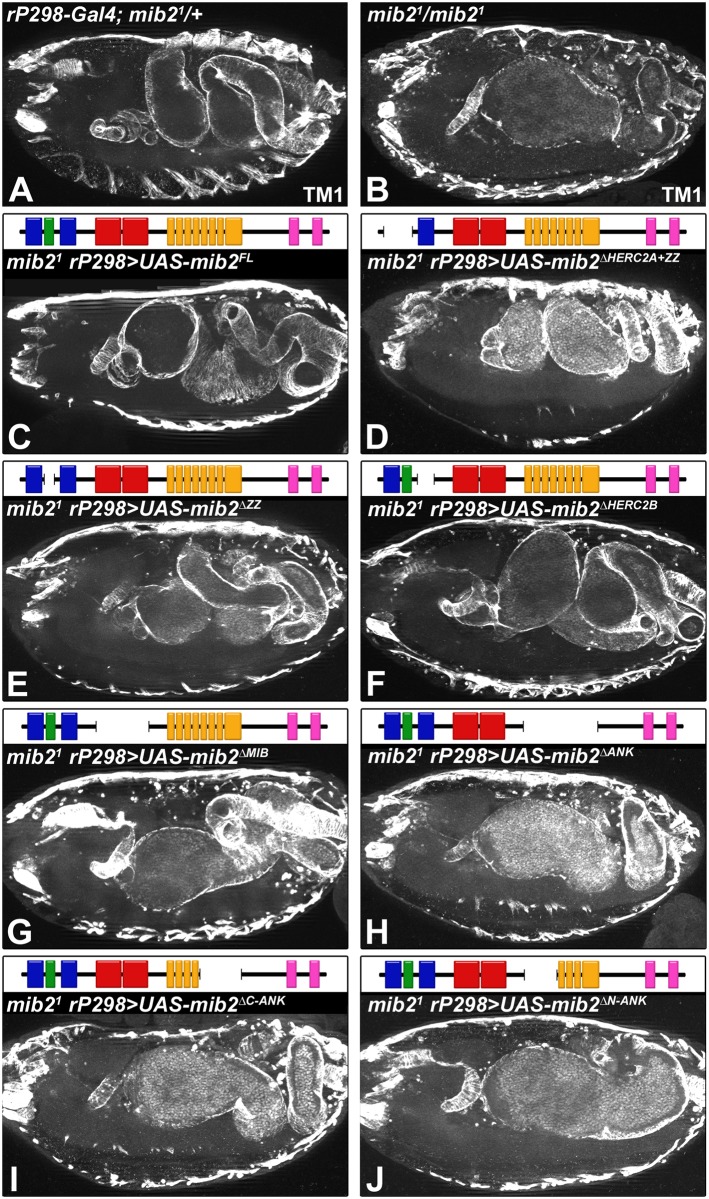
Normal midgut development depends on the MIB domains and all ankyrin repeats.Muscle-specific expression of UAS-mib2 constructs, each with a particular deletion, was achieved with the rP298-Gal4 driver. Late stage 16 embryos were stained with an antibody against Tropomyosin 1 (Tm1) and analyzed by fluorescent microscopy. For each indicated genotype, the examples shown herein are representative for all embryos (n≧5). (A) Heterozygous mib2 embryo with one copy of the driver rP298-Gal4 shows a well-formed midgut with proper constrictions. (B) Homozygous mib2 mutant embryo exhibits a characteristic “bloated” midgut without constrictions. Normal midgut formation and morphogenesis is restored in homozygous mib2 mutant embryos with UAS-mib2FL (C; encoding full-length Mib2), UAS-mib2ΔHERC2A+ZZ (D; Mib2 without the HERC2A and ZZ domains), UAS-mib2ΔZZ (E; Mib2 without the ZZ domain) or UAS-mib2ΔHERC2B (F; Mib2 without the HERC2B domain). A”bloated”, unconstricted midgut is observed in homozygous mib2 mutant embryos lacking the MIB-specific domain (UAS-mib2ΔMIB in G) or portions of the ankyrin repeat (UAS-mib2ΔANK in H, UAS-mib2ΔC-ANK in I and UAS-mib2ΔN-ANK in J).